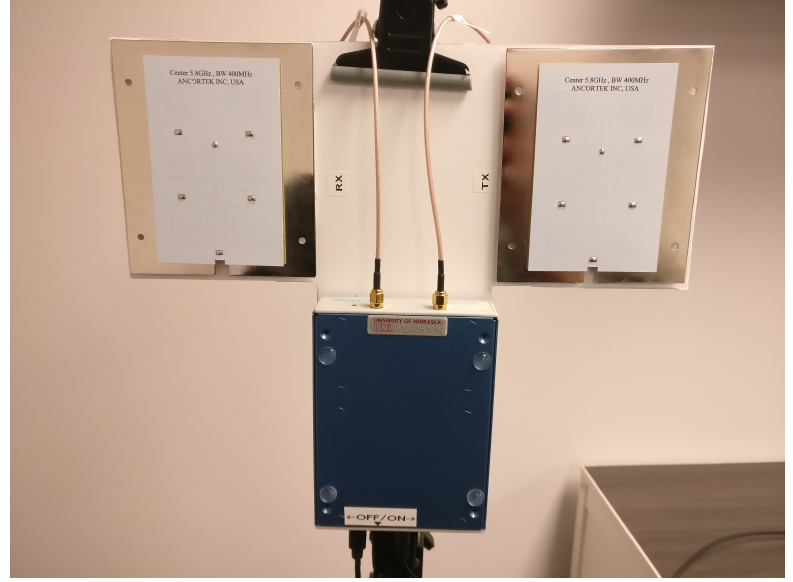
Figure 9. SDR-kit 580AD experimental setup. Table 4. Comparison of Processing time for fish-eye